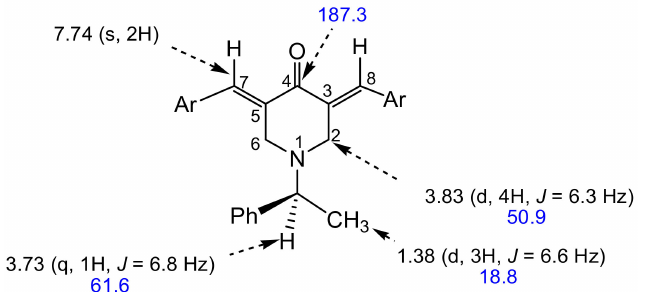
Figure 2. Selected 1 H (black) and 13 C (blue) chemical shifts of optically active compound 1d . The (E,E) configuration of the two exocyclic carbon-carbon double bonds in